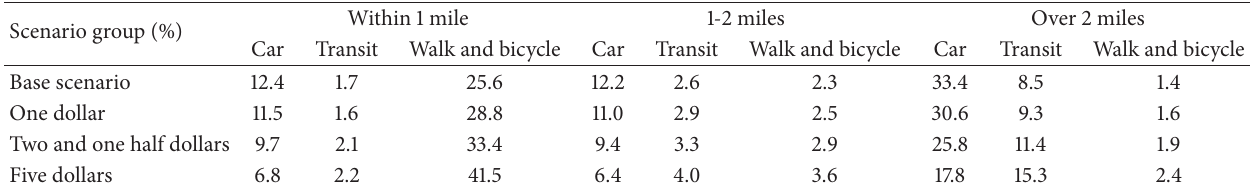
Table 7: Predicted shares based on different